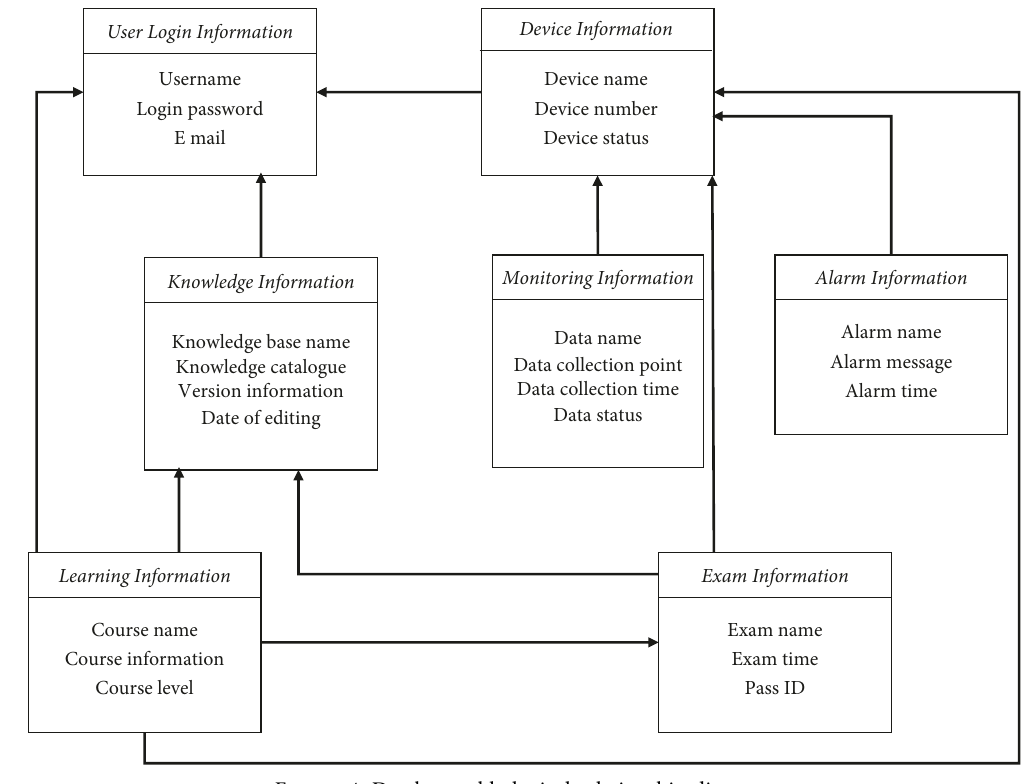
Figure 4: Database table logical relationship diagram.